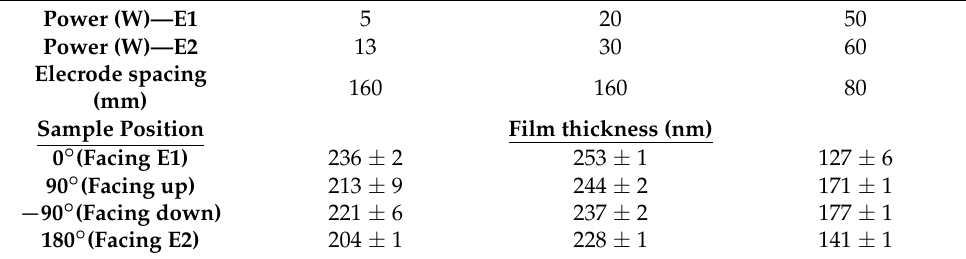
Table 1. Deposition parameters and ellipsometry film thicknesses for RF TMDSO